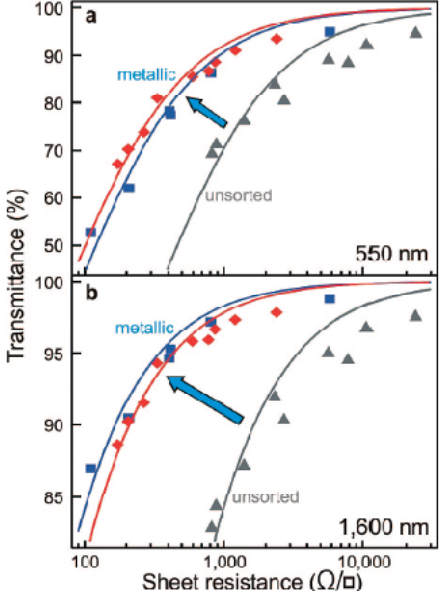
Figure 2. Transmittance versus sheet resistance of transparent conductive films generated from CNTs at ( a ) 550 nm; and ( b ) 1600 nm wavelengths. The materials used were metallic CNTs with principal diameters of 0.9 nm (red diamond symbols), 1.0 nm (blue square symbols) and a mixture of metallic and semiconducting CNTs (gray triangle